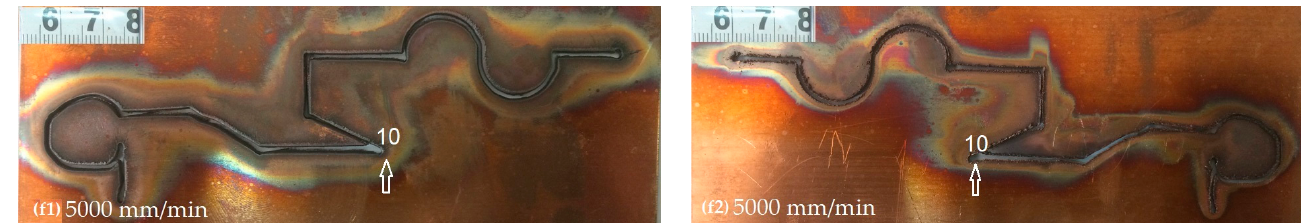
Figure 10. The cutting path width of ( f1 , f2 ) at 5000 mm/min at 30 A for Point 10. At 500 mm/min, Point 11 (the obtuse angle on the cutting path) recorded a lower cutting width of 1.494 mm (Figure 6). In comparison, at 4000 mm/min, the same point was recorded (Figure 7) as a below-average reading when the cutting width was 2.023 mm. This result confirmed that the obtuse angle’s cutting width increased slightly by decreasing the cutting feed rate and that the cutting quality decreased with it. However, the rest of the points recorded lower readings for the cutting